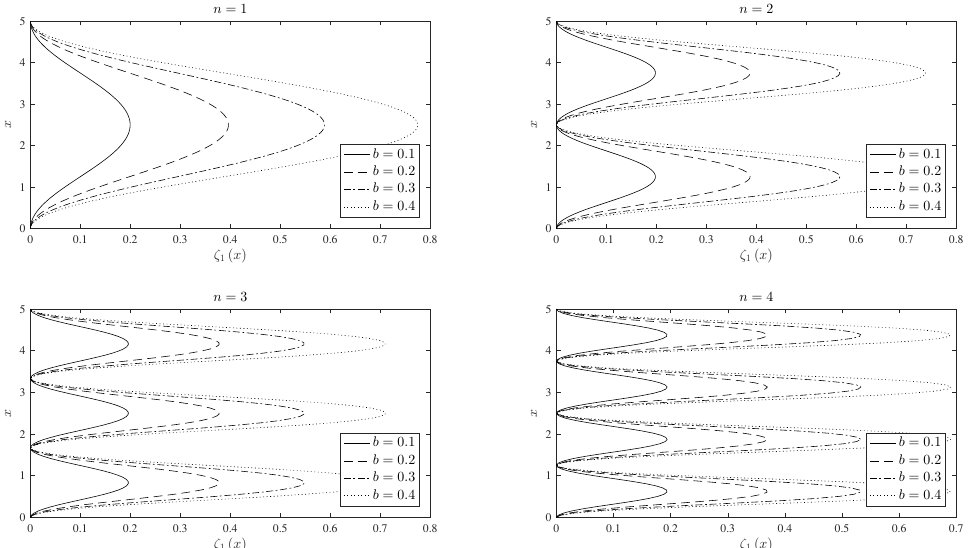
Figure 11. Different mode shapes of the buckled elastic clamped beam for the four lowest buckling forces, n = 1, . . . ,4, as functions of the indeterminate constant b . The length of the beam is L = 5.